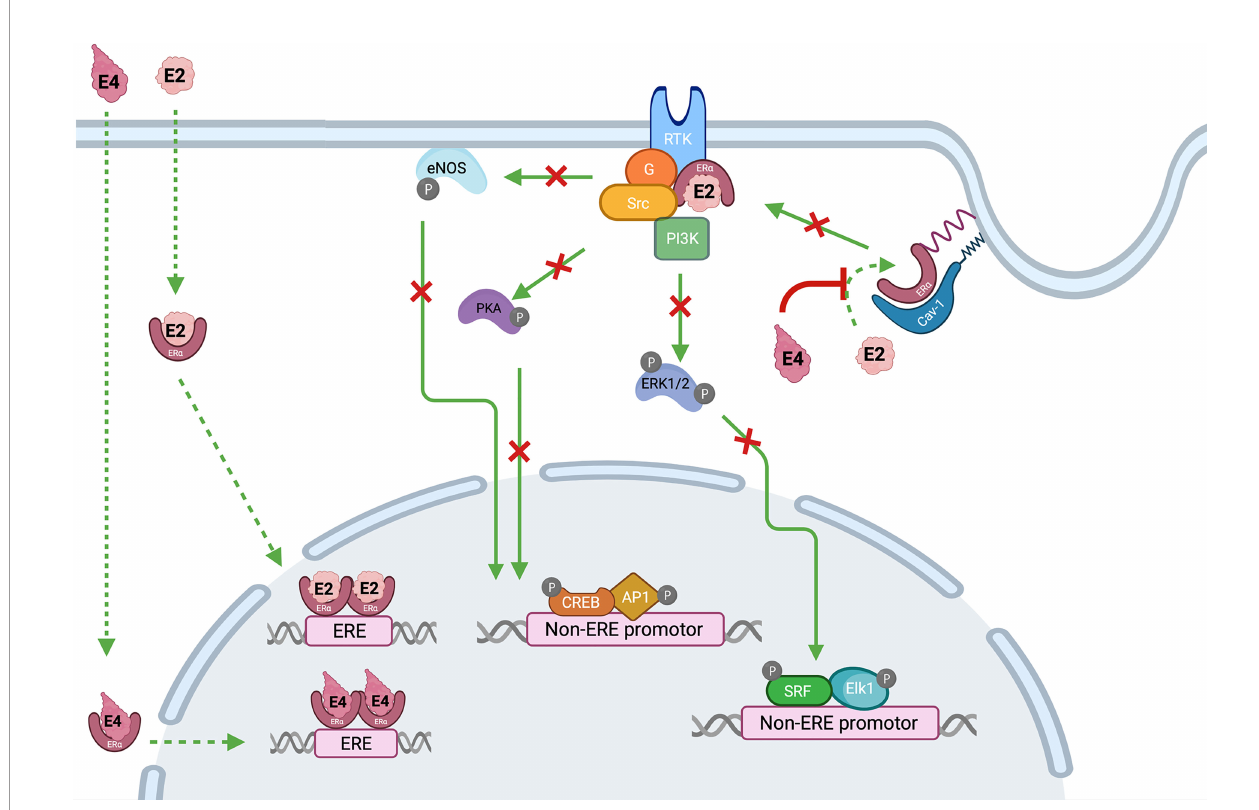
FIGURE 6 | Interaction between estrogens, i.e., estradiol (E2) and estetrol (E4) and estrogen receptors alpha (ER a ). Estradiol activates both membrane and nuclear actions of ER a while E4 is an agonist of nuclear activity but an antagonist of the ER a -dependent MISS pathway. Nuclear activity is the result of an interaction between estrogens, i.e., E2 or E4, and the ER a located in the cytoplasm. This binding leads to the dimerization and the translocation of the complex into the nucleus, where it interacts with ERE DNA sequences in target genes. The ER a -dependent MISS pathway consists of a rapid nongenomic activity playing an important role in the endothelial effect of estrogens. Palmitoylation of ER a allows them to anchor to the plasma membrane caveolae where they associate with caveolin-1 (Cav-1). Upon E2 stimulation, ER a is de-palmitoylated and dissociated from Cav-1, to interact with protein kinase (Src and PI3K), G-coupled protein ai (Gai) leading to signaling cascade (Akt, Pka, ERK1/2) and endothelial NO synthase activation. On the other hand, E4 is devoid of ER a MISS activity and even, is also able to antagonize E2- induced MISS effect, especially in the endothelium. AP1, activator protein 1; Cav-1, caveolin 1; CREB, cAMP-response element-binding; Elk1, ETS like-1 protein; ERK, extracellular signal-regulated kinases; eNOS, endothelial nitric oxide synthase; ER, estrogen receptor; ERE, estrogen responsive element; E2, estradiol; E4, estetrol; G, G protein (sub-unit ai); MISS, membrane-initiated steroid signaling; PI3K, phosphoinositide 3-kinase; RTK, receptor tyrosine kinase; SRF, serum response